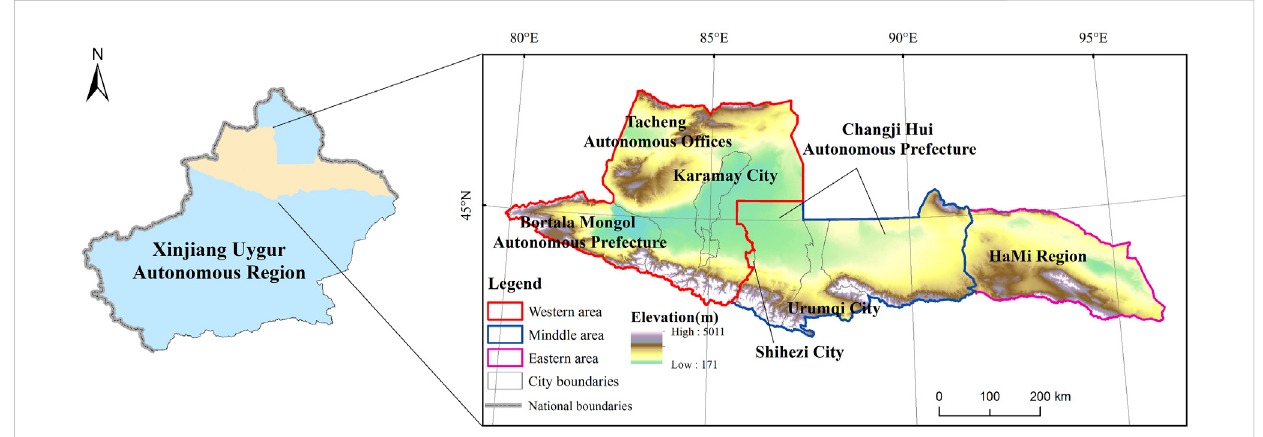
Geographical location and segmental boundary on the northern slopes of the Tianshan